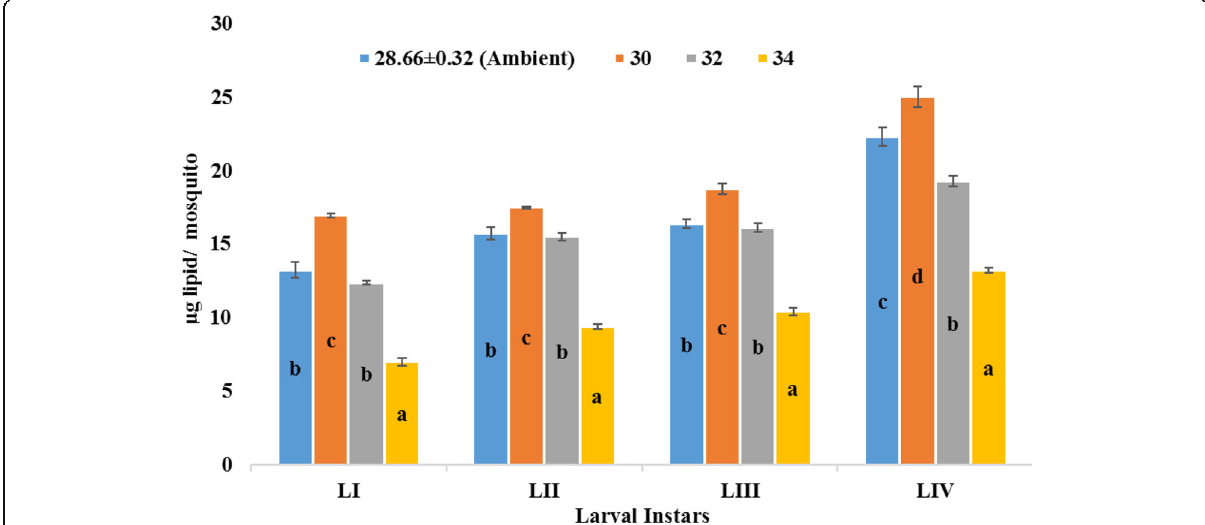
Fig. 4 Effects of rearing-water temperature on teneral lipid accumulation across larval instars (LI – IV) of Culex quinquefasciatus mosquito. Temperature bars with same letter at each larval instar are not significantly different at p <0.05 according to analysis of variance. Values are expressed as mean±SD